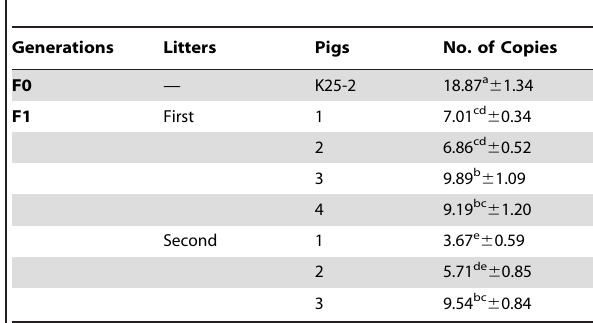
Table 2. Copy number of GFP in K25-2 and its